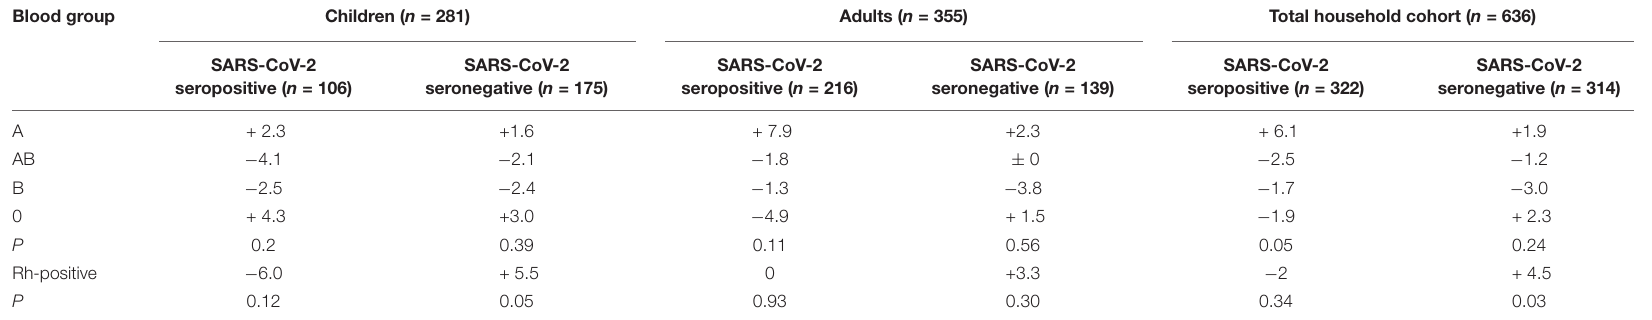
TABLE 2B | Differences in the frequency of each blood group among SARS-CoV-2 seropositive and seronegative individuals compared to the reference